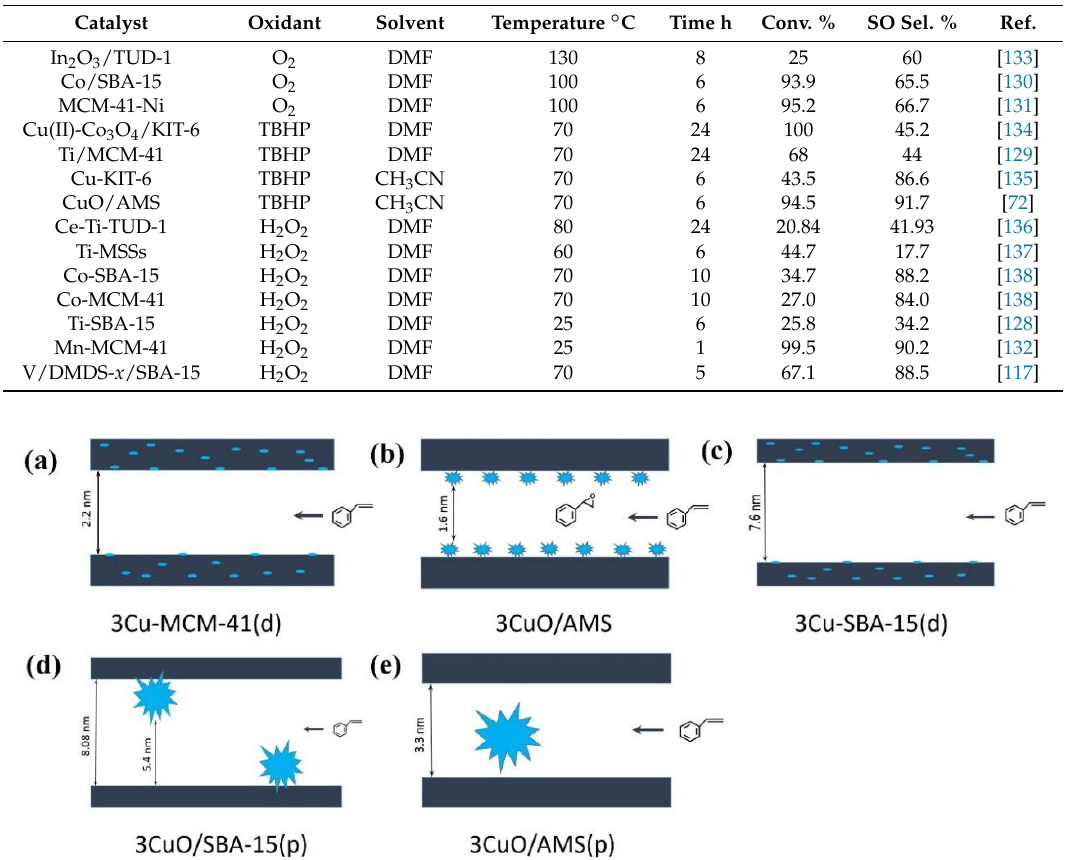
Figure 15. Possible reaction mechanism for the epoxidation of styrene on Mn-MCM-41. Reprinted from Ref. [132], Copyright 2014, with permission from Elsevier. Table 2. Catalytic properties of different catalysts on styrene oxidation.